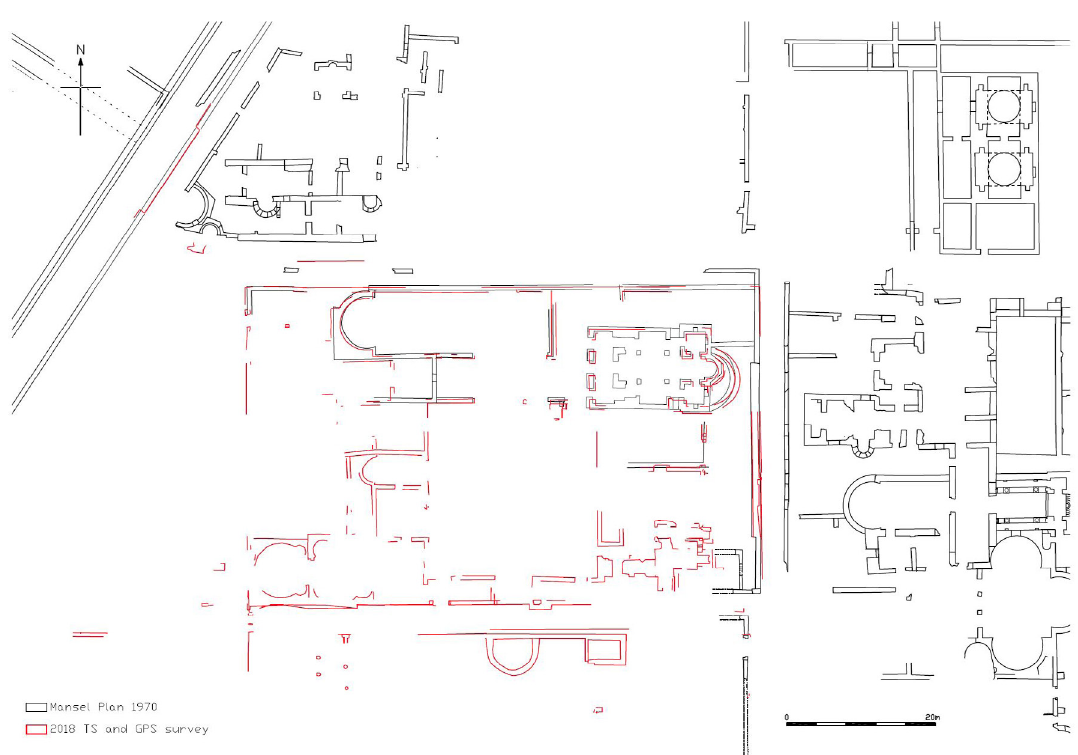
Figure 11. TS and GPS-RTK 2018 survey together with previous interventions © ÖAW/IKAnt (M. Hernández